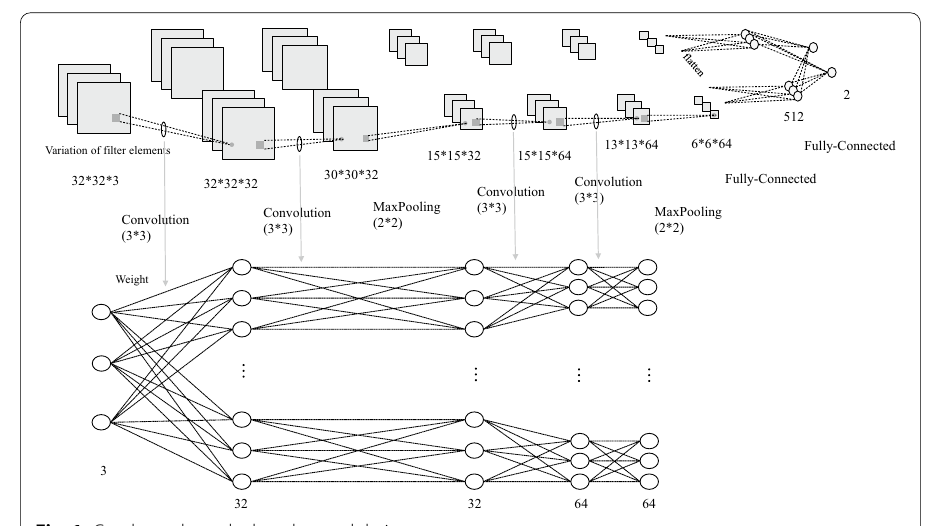
Fig. 1 Graph used to calculate the